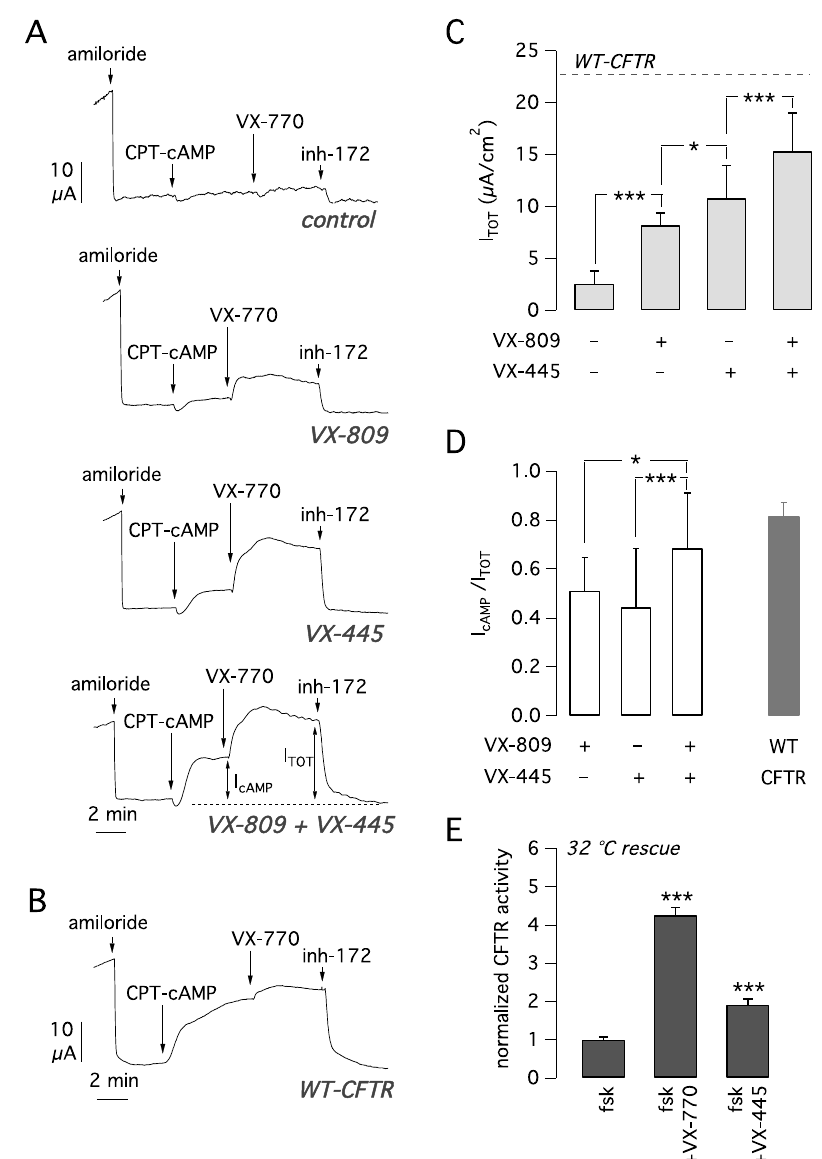
Figure 2. Functional evaluation of VX ‐ 445 corrector activity in human bronchial epithelial cells. ( A ) Effect of 24 h cell treatment with vehicle alone (DMSO), VX ‐ 445 (5 μ M), VX ‐ 809 (1 μ M), or both correctors together. Experiments were done on F508del/F508del bronchial epithelial cells derived from 5 different subjects (BE86, BE91, BE93, BE111, and BE115) with the short ‐ circuit current technique. Representative recordings are from BE115. As parameters of CFTR function, we measured the total current sensitive to inh ‐ 172 (I TOT ) and the current elicited by the cAMP analog alone (I cAMP ). ( B ) Representative trace obtained from short ‐ circuit current recordings on non ‐ CF bronchial epithelial cells (BE99). ( C ) Summary of I TOT (mean ± SD, n = 26–31) measured in F508del/F508del epithelia, derived from 5 different subjects (BE86, BE91, BE93, BE111, and BE115), exposed to indicated treatments. The dashed line reports the value of I TOT in non ‐ CF bronchial cells. *, p < 0.05; ***, p < 0.001 between indicated groups of data. ( D ) Ratio between the current elicited by cAMP stimulation (I cAMP ) and total CFTR current (I TOT ) in F508del/F508del epithelia treated with the indicated compounds (data obtained from experiments shown in A and C ). *, p < 0.05; ***, p < 0.001 between indicated groups of data. ( E ) Evaluation of VX ‐ 445 as potentiator on F508del ‐ CFTR CFBE41o ‐ cells rescued at 32 °C for 24 h (mean ± SD, n = 5). ***, p < 0.001 vs. control. Experiments on airway epithelial cells were also done by combining VX ‐ 445 with VX ‐ 661 since these two correctors are the ones included in the Trikafta ® /Kaftrio ® medication [13]. The experiments were done on epithelia derived from four F508del homozygous